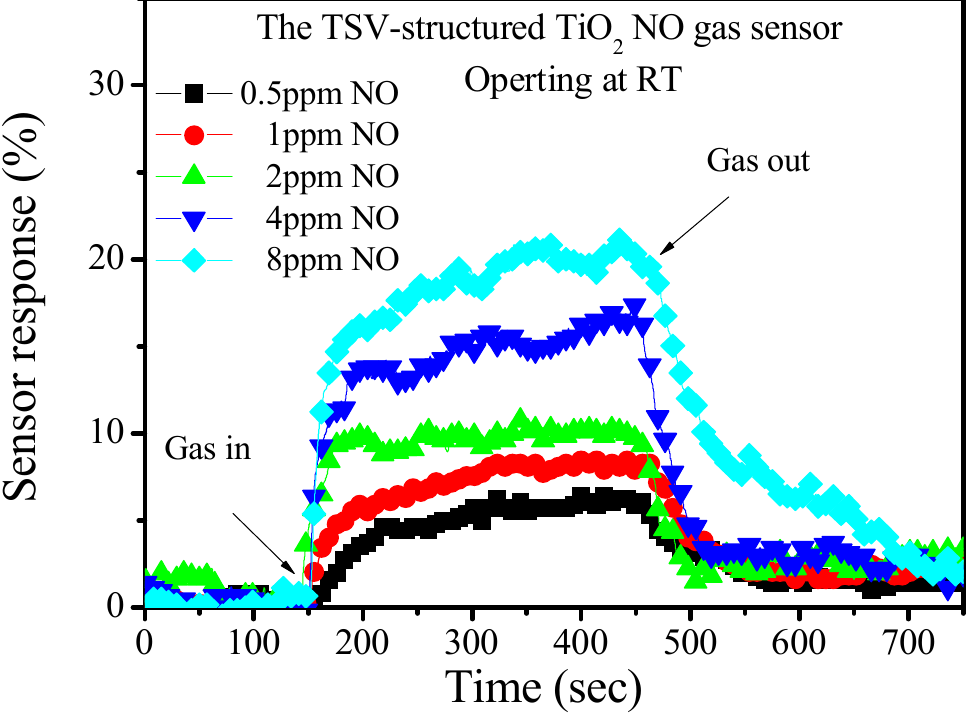
Figure 7. The sensor response for various concentrations.